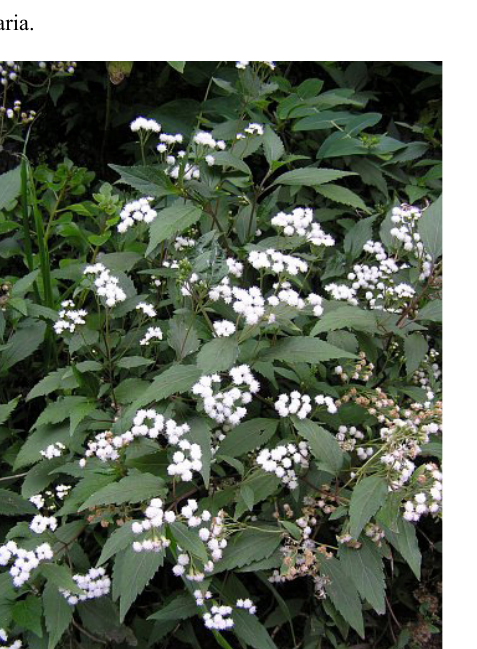
Figure 2: The habit of Ageritina riparia.